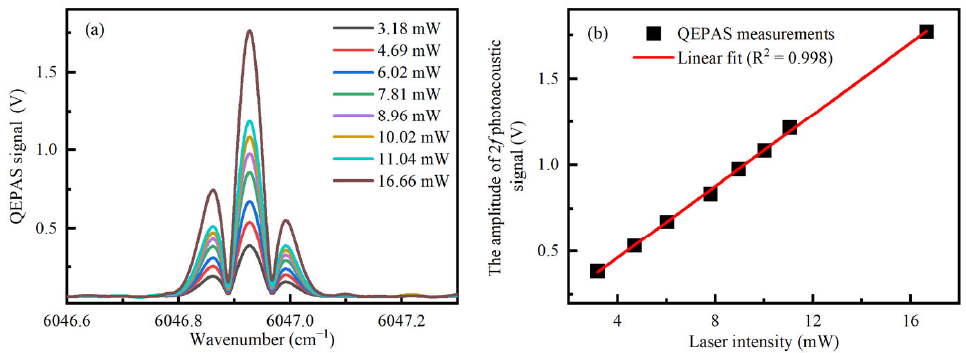
Figure 4. QEPAS system measurements at different light intensities. ( a ) The 2 f photoacoustic signal at different light intensities; and ( b ) linear fitting curve of the amplitude of the 2 f photoacoustic signal at different light intensities.